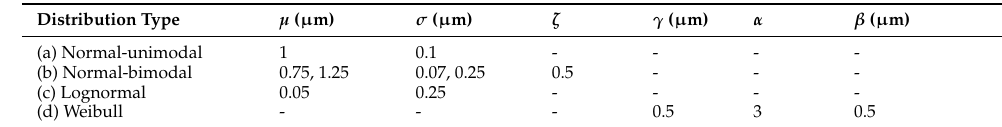
Figure 4. Comparison of the numerical and analytical 2D and 1D distributions of the radii of cross-sections and linear intercepts considering ( a ) a normal distribution, ( b ) a bimodal distribution, ( c ) a log-normal distribution, and ( d ) a Weibull distribution. The 3D distribution is shown in the solid black line. The numerically generated 2D and 1D distribution functions are shown in the red and blue crosses, respectively. Table 2. The parameters to generate different shapes of particle size distributions, corresponding to the waveforms presented in Table